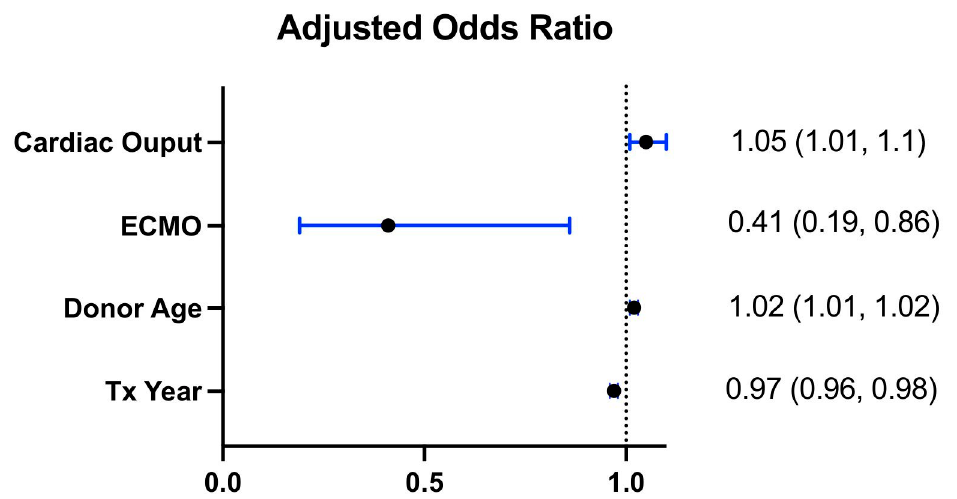
Figure 3. Forest plots indicating adjusted odds ratios for predictors of the need for pacemaker implantation post heart transplantation.